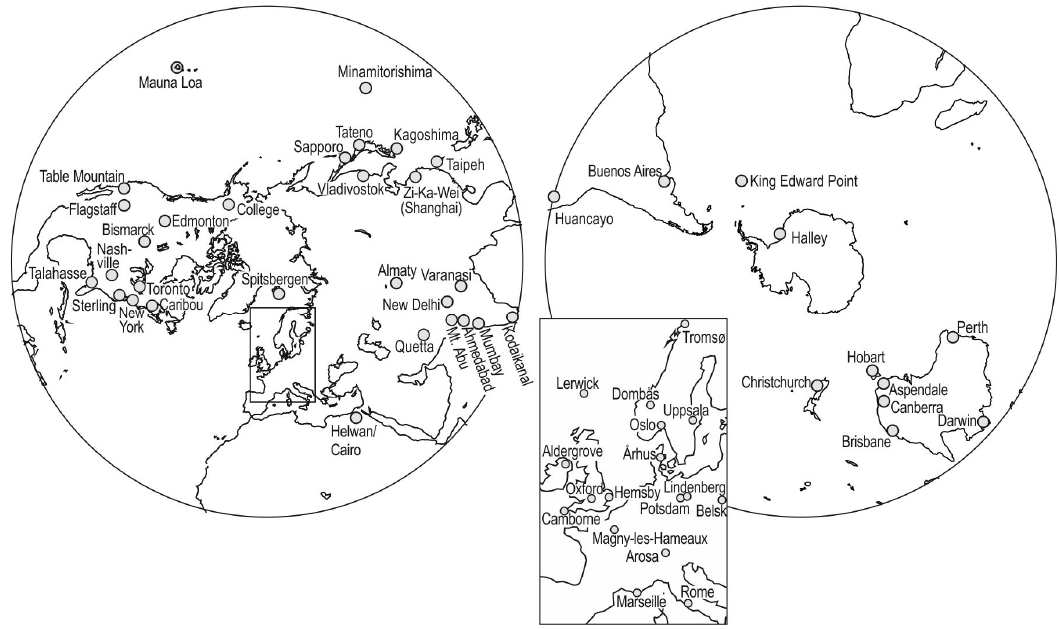
Fig. 1. Map showing the locations of the ground-based total column ozone stations used in this study.